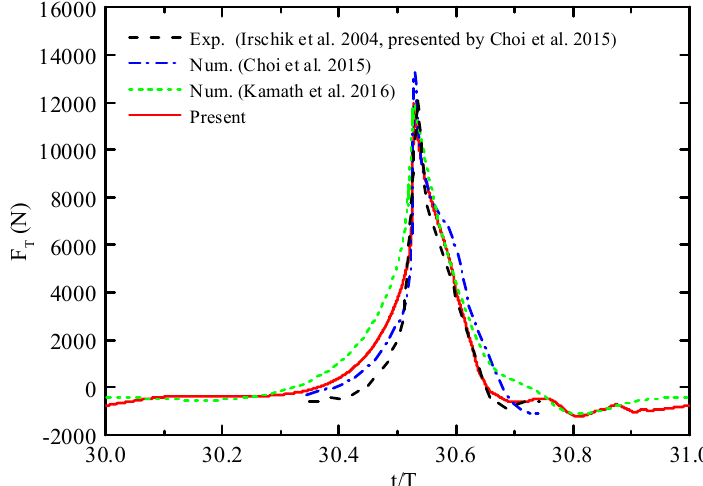
Figure 6. Comparison of breaking wave forces between the present result and the published data for the vertical cylinder.